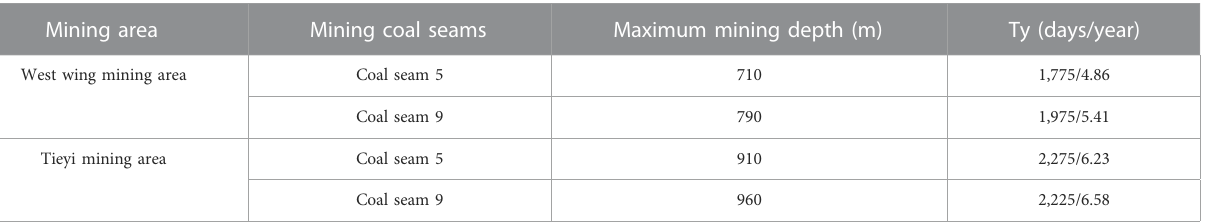
TABLE 3 Ty calculation results of coal seams 5 and 9 in Tangshan mine.